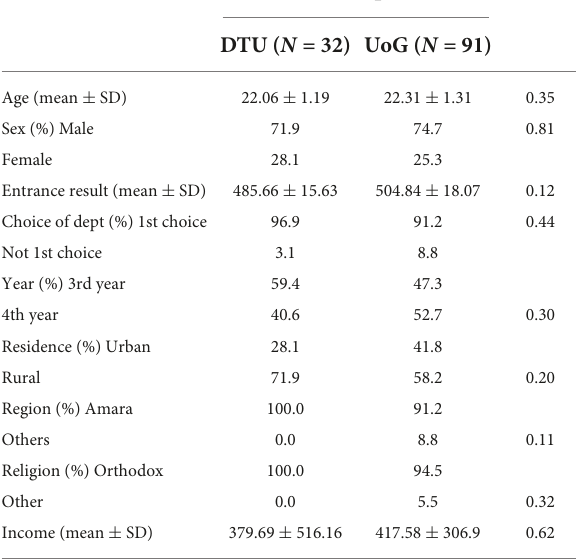
TABLE 1 Sociodemographic characteristics of the study participants at Debre Tabor University (DTU) and University of Gondar (UoG), 2021.